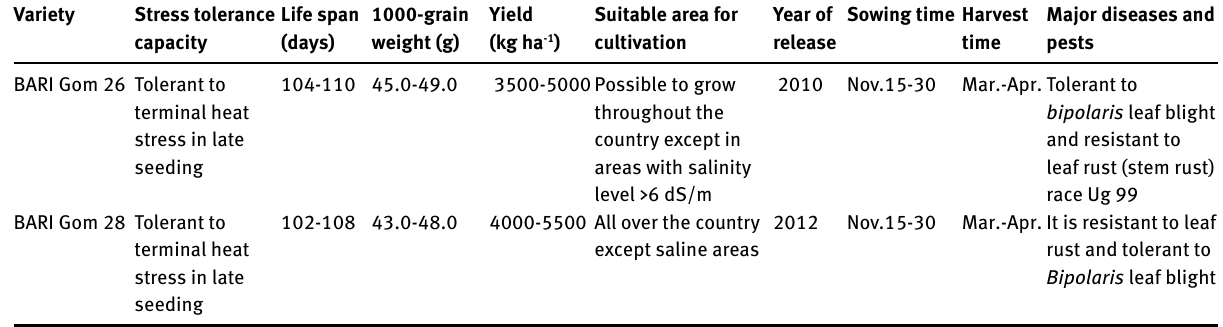
Table 2: Characteristics of wheat varieties BARI Gom 26 and BARI Gom 28 used in the study. Source: BARI (2016)